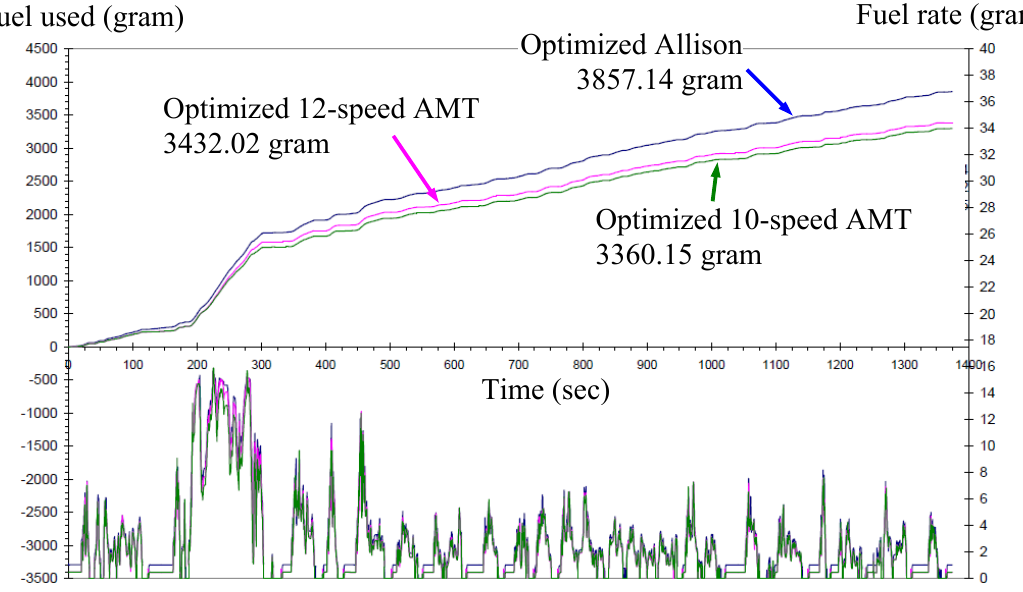
Figure 8. Comparison of fuel consumption based on optimized shift